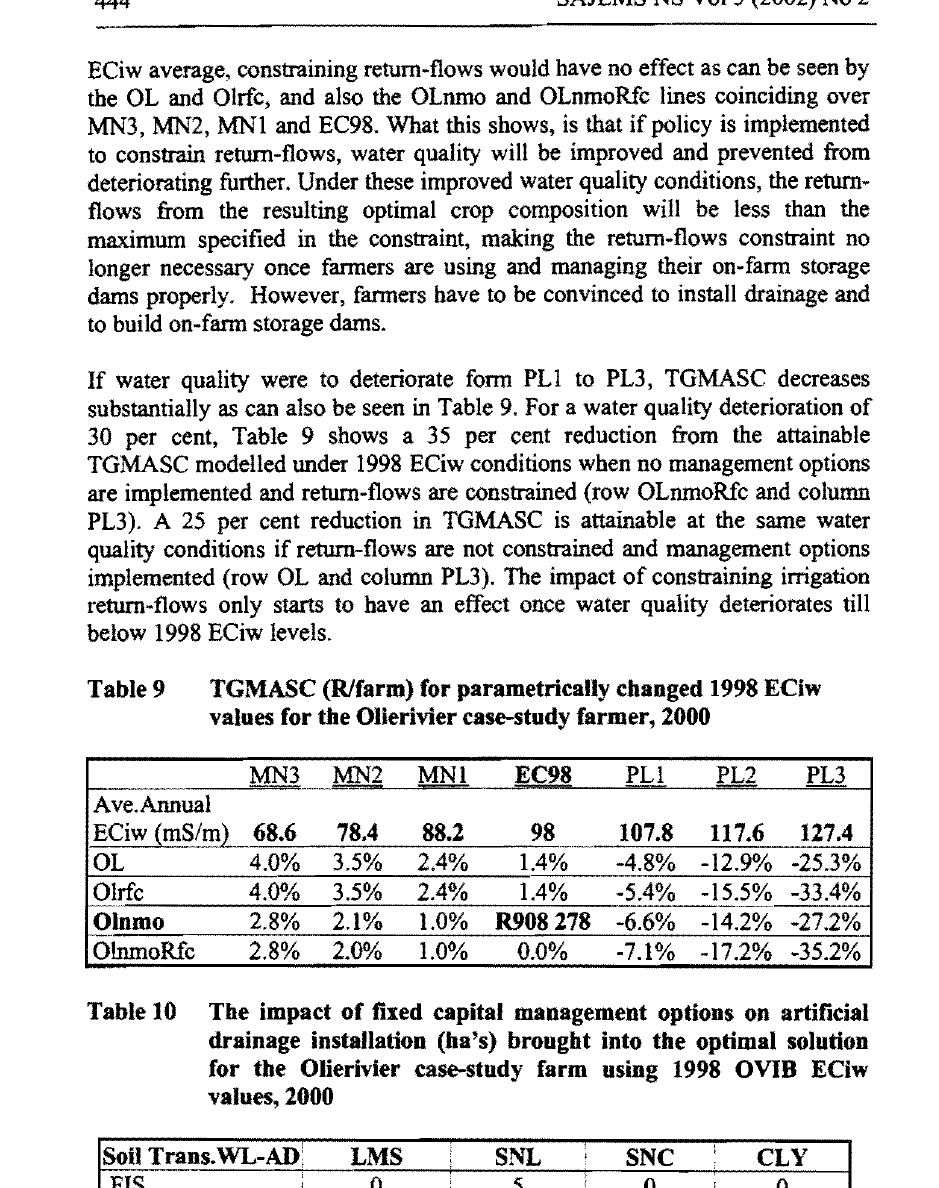
The impact of fixed capital management options on artificial drainage installation (ha's) brought into the optimal solution for the Olierivier case-study farm using 1998 OVID ECiw values,